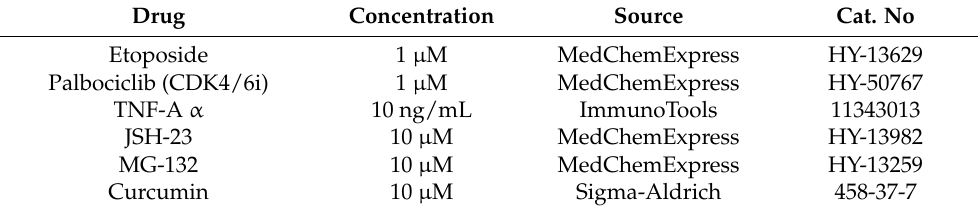
Table A1. List of drugs.